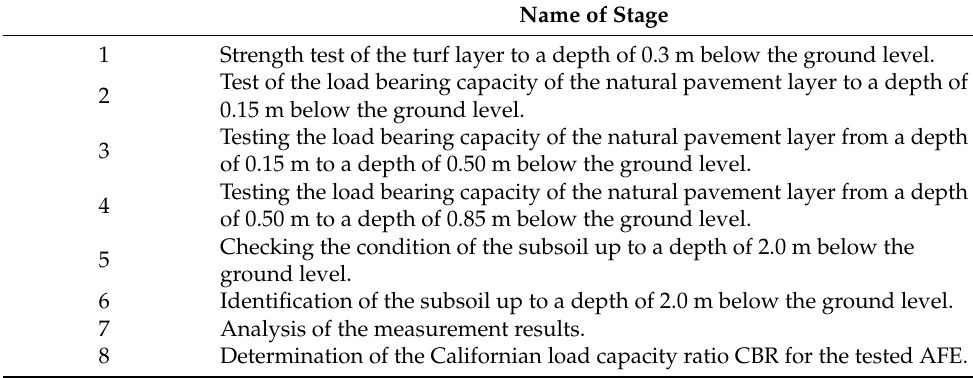
Table 1. Stages of a comprehensive assessment of the load bearing capacity of natural airfield pavements [34].